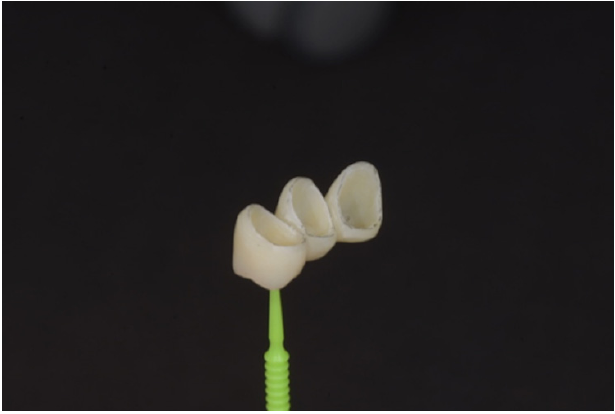
Figure 2. Preparation of the abutments (teeth #43, #44, #45).